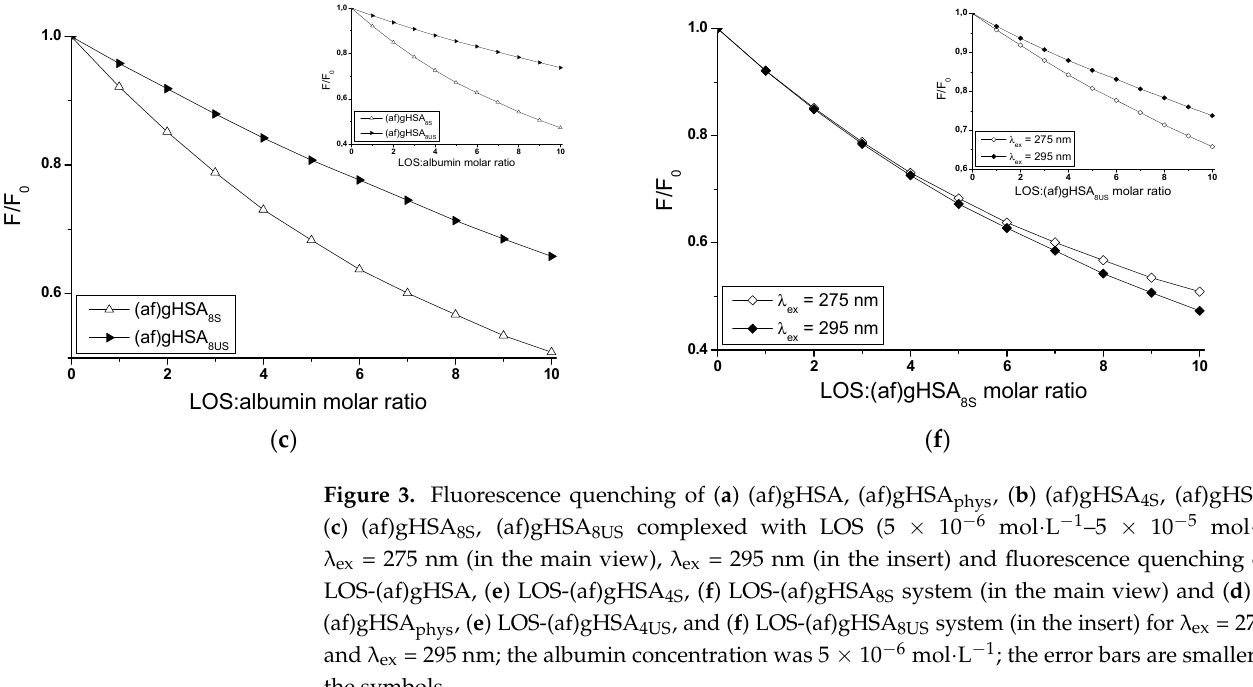
Figure 3. Fluorescence quenching of ( a ) (af)gHSA, (af)gHSA phys , ( b ) (af)gHSA 4S , (af)gHSA 4US , ( c ) (af)gHSA 8S , (af)gHSA 8US complexed with LOS (5 × 10 − 6 mol ∙ L − 1 –5 × 10 − 5 mol ∙ L − 1 ), λ ex = 275 nm (in the main view), λ ex = 295 nm (in the insert) and fluorescence quenching of ( d ) LOS-(af)gHSA, ( e ) LOS-(af)gHSA 4S , ( f ) LOS-(af)gHSA 8S system (in the main view) and ( d ) LOS-(af)gHSA phys , ( e ) LOS-(af)gHSA 4US , and ( f ) LOS-(af)gHSA 8US system (in the insert) for λ ex = 275 nm and λ ex = 295 nm; the albumin concentration was 5 × 10 − 6 mol ∙ L − 1 ; the error bars are smaller than the symbols.